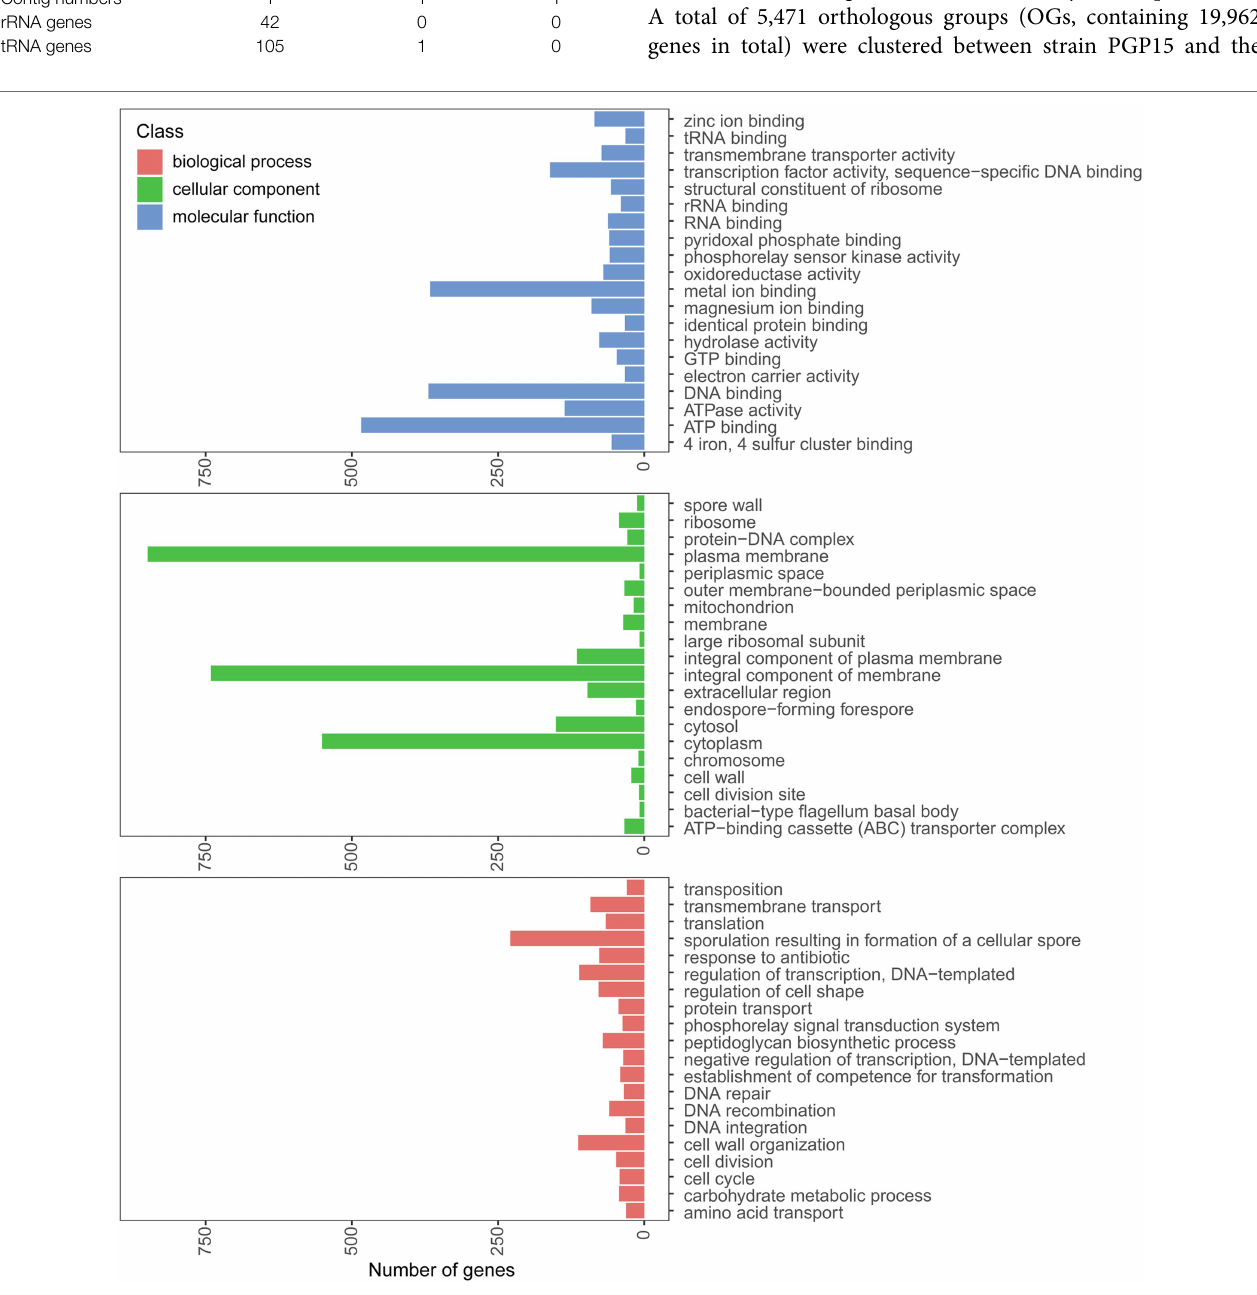
FIGURE 5 | Annotation of genes in the PGP15 genome. The GO categories belonging to biological process, cellular component, and molecular function are shown.